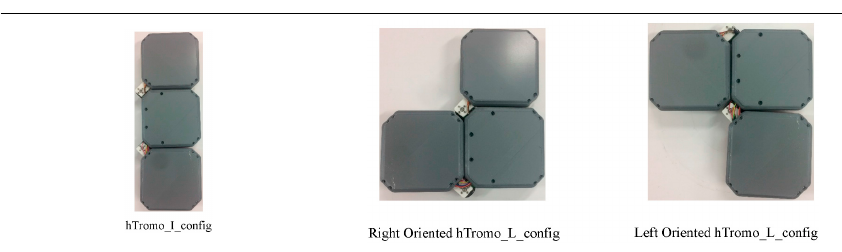
Table 1. Cont. Appl. Sci. 2018 , 8 , x